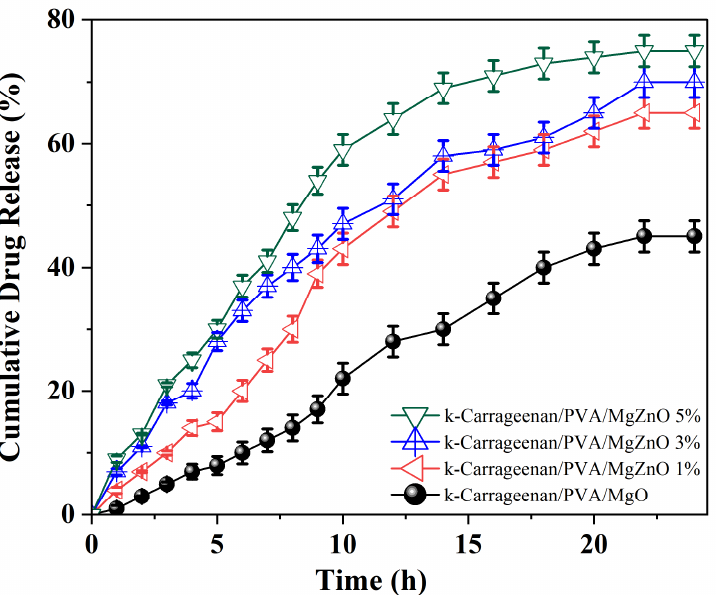
Figure 3. The in vitro release profile of catechin from Ca/PVA nanocomposites with different ZnO ratios. Data represent mean ± SD ( n = 3). ratios. Data represent mean ± SD ( n =